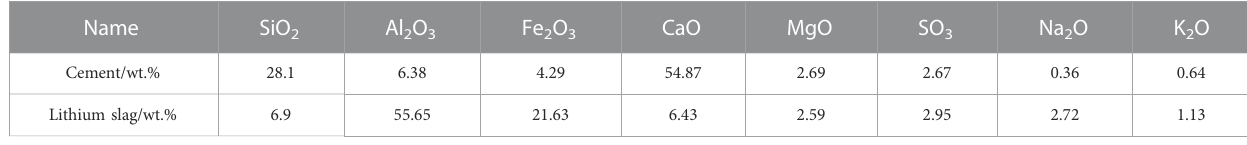
TABLE 1 Chemical composition of cement and lithium slag.